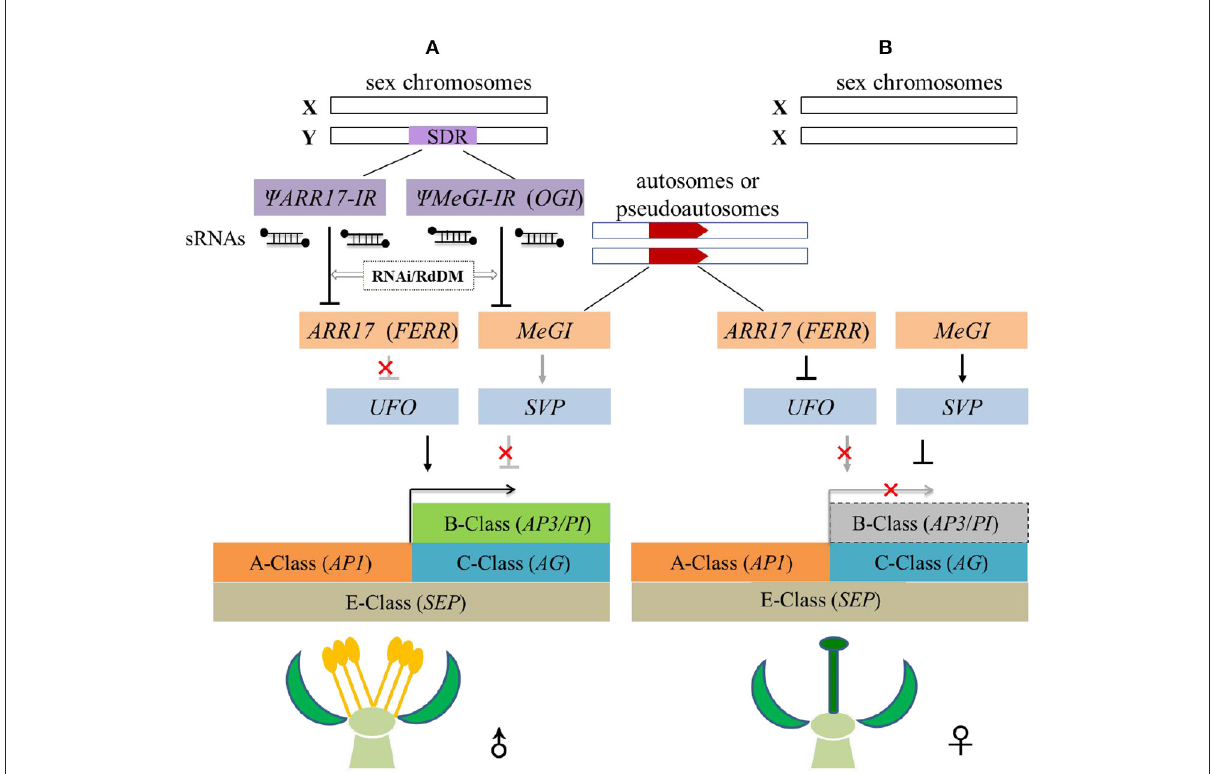
FIGURE4 Convergent model of sex-regulation cascades from upstream sex-determining genes to downstream B-class genes in dioecious plants. (A) Duplicated pseudogenes ( Ψ ARR17-IR or Ψ MeGI-IR ) in the SDR of the Y chromosome generate sRNAs that dominantly repress their counterpart feminizing factors ( ARR17 or MeGI ) on autosomes/pseudo autosomes via epigenetic RNAi/RdDM pathway. Downstream B-class genes are activated either by the expression of activator ( UFO ) or the suppression of repressor ( SVP ), producing only male flowers. (B) In XX individual, no pseudogenes of feminizing factors are available, repressor ( SVP ) of B-class genes are thus expressed, or activator ( UFO ) is repressed, and the expression of B-class genes are suppressed forming only female